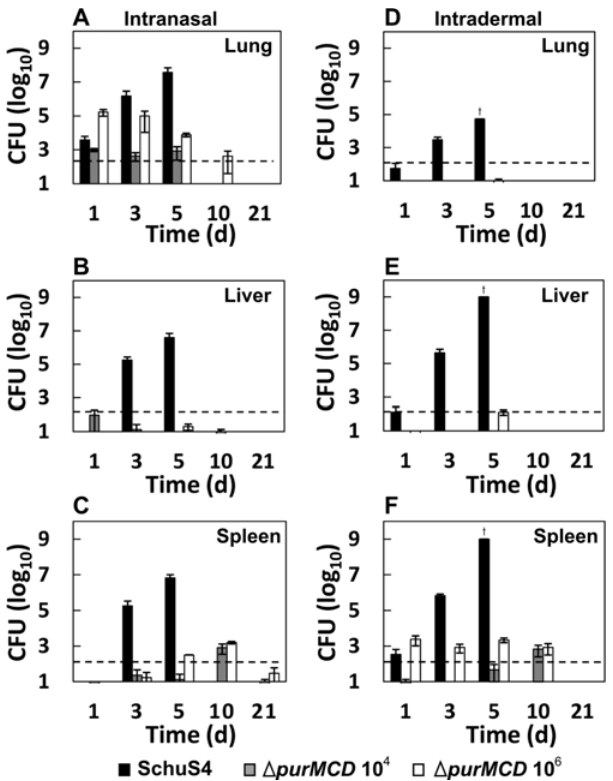
Figure 2. Growth characteristics of Schu S4 derivatives in BALB/c mice. Groups of mice were infected i.n. (A, B, and C) or i.d. (D, E, and F) with wild-type Schu S4 (50 CFU), or one of two doses of Schu S4 D purMCD (10 4 or 10 6 CFU). At specific times after infection, subsets of mice were sacrificed and the numbers of bacteria present in the lungs (A and D), livers (B and E), or spleens (C and F) were determined by plating organ homogenates on MH agar containing ampicillin (50 m g/ml). Values represent the mean log CFU per ml from groups of three animals each. The horizontal dashed line represents the confidence level of detection for the assay. Standard errors of organ burdens for three individual mice are shown. Crosses indicate time points where n=1; n=3 for all other time